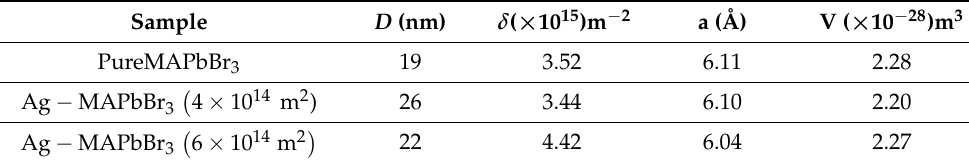
Table 1. The D , δ , a, and V of pure and Ag-implanted MAPbBr 3